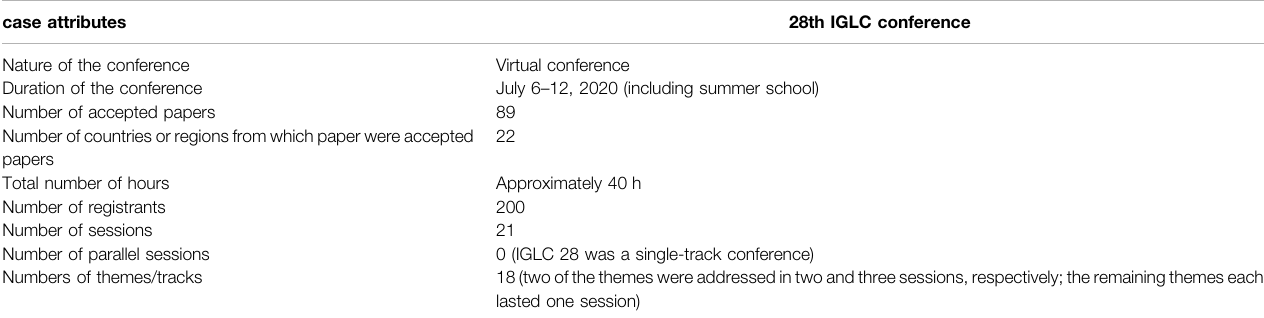
TABLE 3 | Basic characteristics of the 28th International Group of Lean Construction